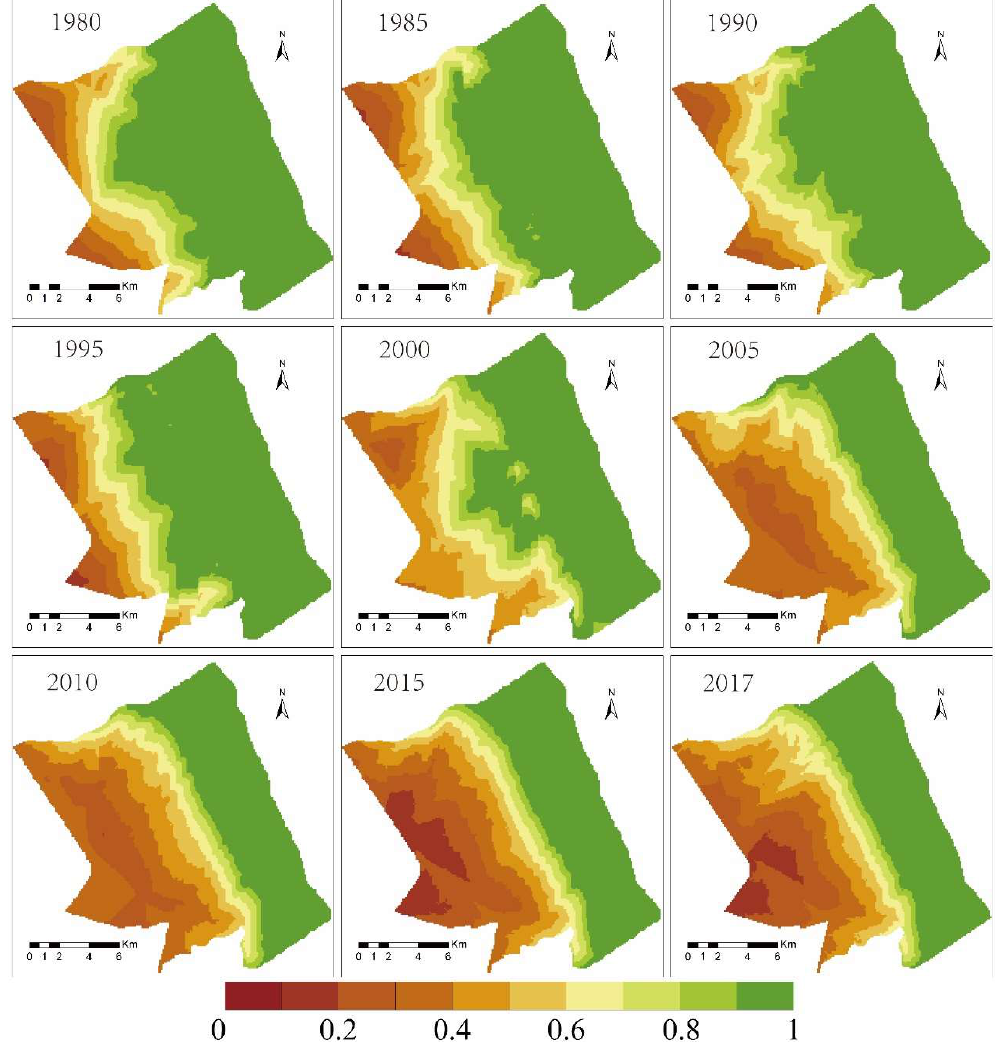
Figure 10. Distribution map of the land–sea material exchange function of the Yancheng coastal wetland. Table 4. Different vegetation areas with different levels of material exchange function from 1980 to 2017. (Unit: ha).